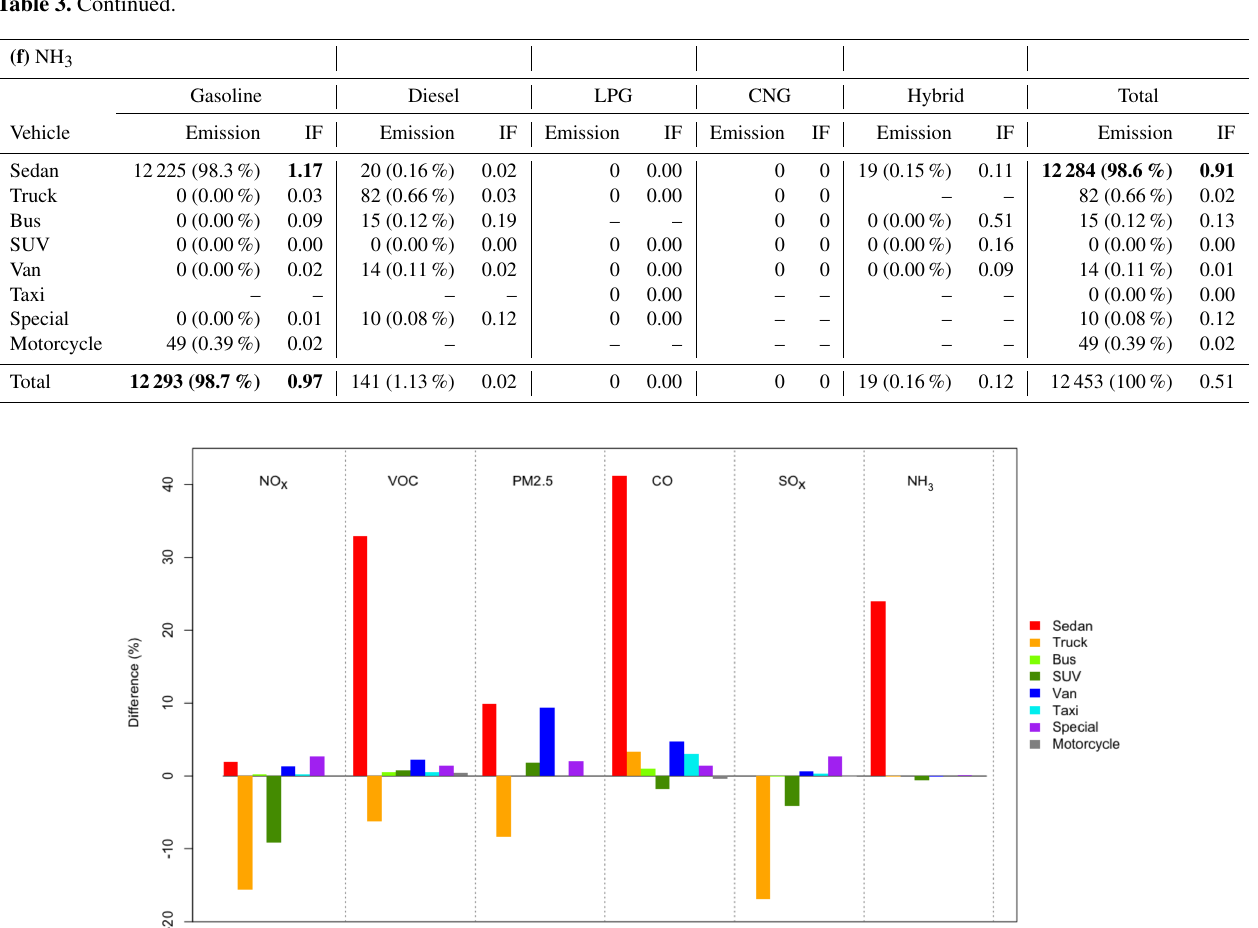
Figure 8. Comparison between CARS 2015 and CAPSS 2015 on-road mobile emissions inventories by vehicle type. The standard line is CAPSS 2015